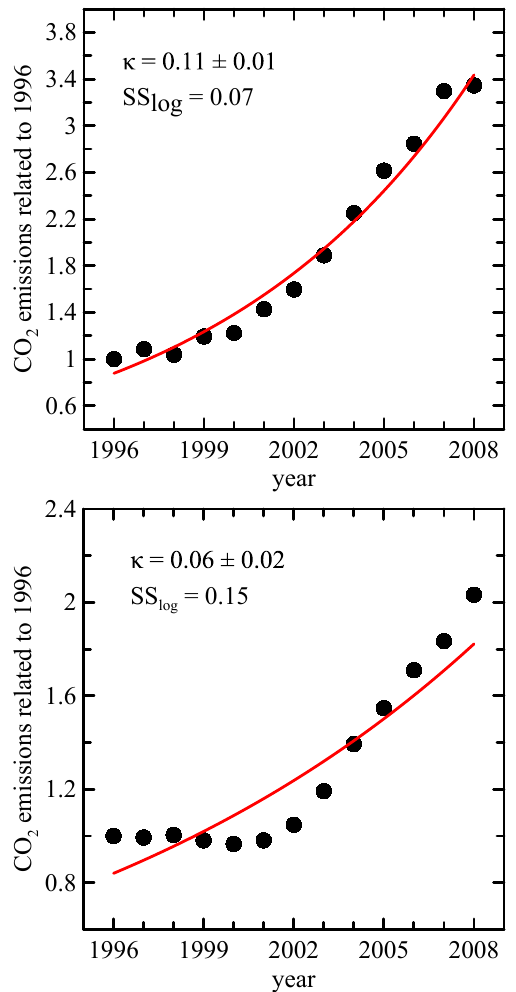
Fig. 7. Multiannual time series of the normalized CO 2 total anthropogenic emissions in China obtained from (a) satellite measurements for case I of the estimation procedure and (b) the EDGAR v4.2 emission inventory, along with corresponding ex- ponential approximations over the whole period from 1996 to